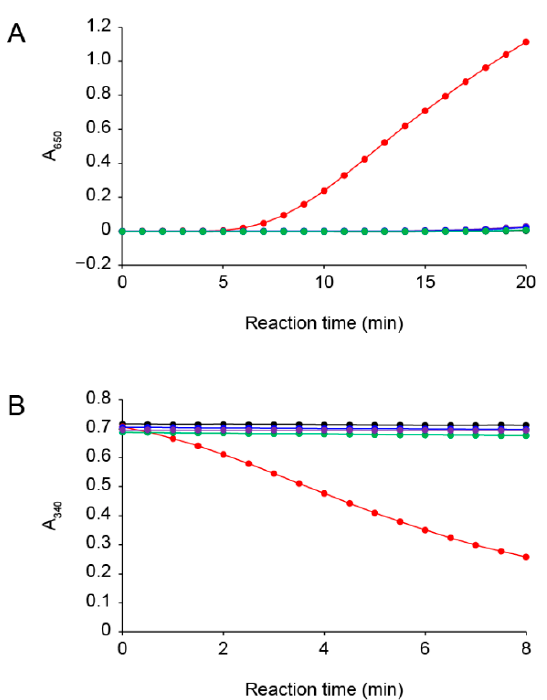
Figure 1. Reduction activity of the Trx system from P. stutzeri F2a. ( A ) Insulin disulfide-reducing activity of PsTrxA with DTT as measured by the increase in A 650 due to the fact of insulin precipitation. ( B ) Selenite reducing activity of PsTrxA with PsTrxR and NADPH as measured by the decrease in A 340 due to NADPH oxidation. PsTrxA proteins used in the assays were wild type (red), C33A (blue), C36A (green), and C33A/C36A (purple). Assays without PsTrxA are shown in black. Representative data obtained for each experiment are shown.